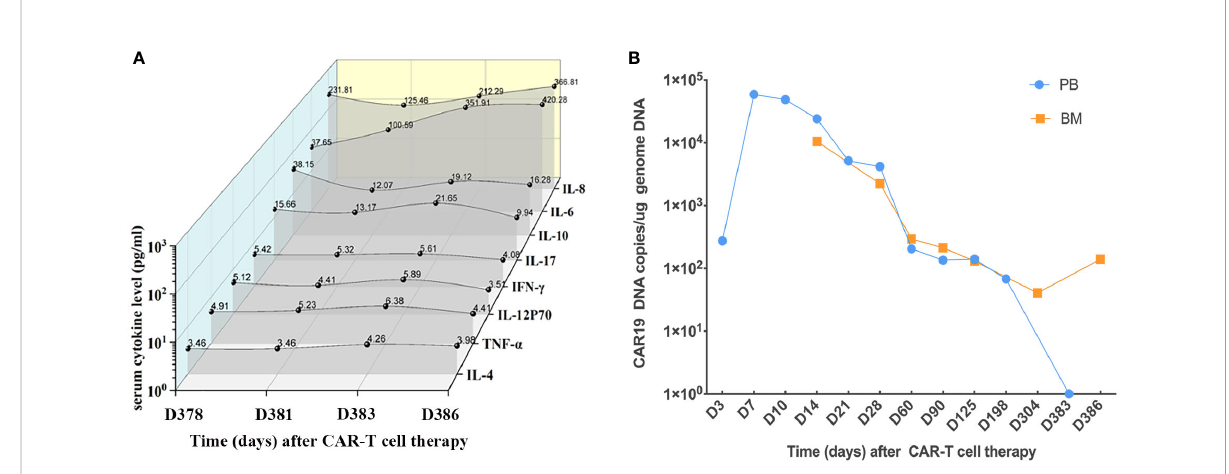
FIGURE 2 Serum cytokines and CAR19 DNA. (A) Serum cytokines of the patient during CAR T-cell therapy since admission. (B) CAR19 DNA in PB and BM since CAR T-cell therapy.